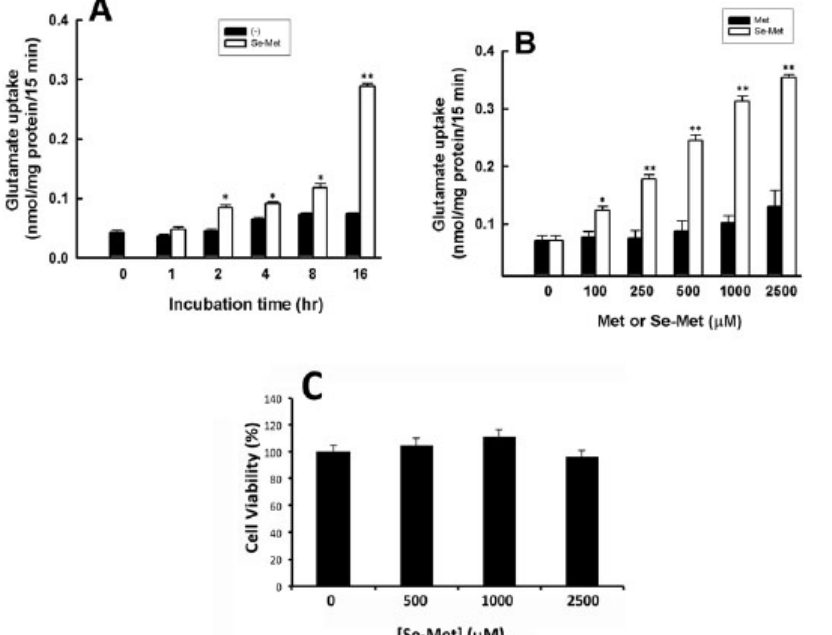
Figure 3. Selenomethionine (Se-Met)-induced stimulation of xc- transport activity is time- and dose-dependent. ( A ) Uptake of [3H]-glutamate (2.5 μM) was measured for 15 min in ARPE-19 cells cultured in the presence or absence of Se-Met (1 mM) for 0–16 h. Uptake was monitored at 37 °C in the absence of Na+. ( B ) Na+-independent [3H]-glutamate (2.5 μM) uptake was measured for 15 min in ARPE-19 cells cultured in the presence or absence of varying concentrations (0–2500 μM) of selenomethionine (Se-Met) or methionine (Met) for 16 h. (* p < 0.05; ** p < 0.01; compared to cor- responding concentration of Met). ( C ) Cell viability was determined by trypan blue exclusion as- say.